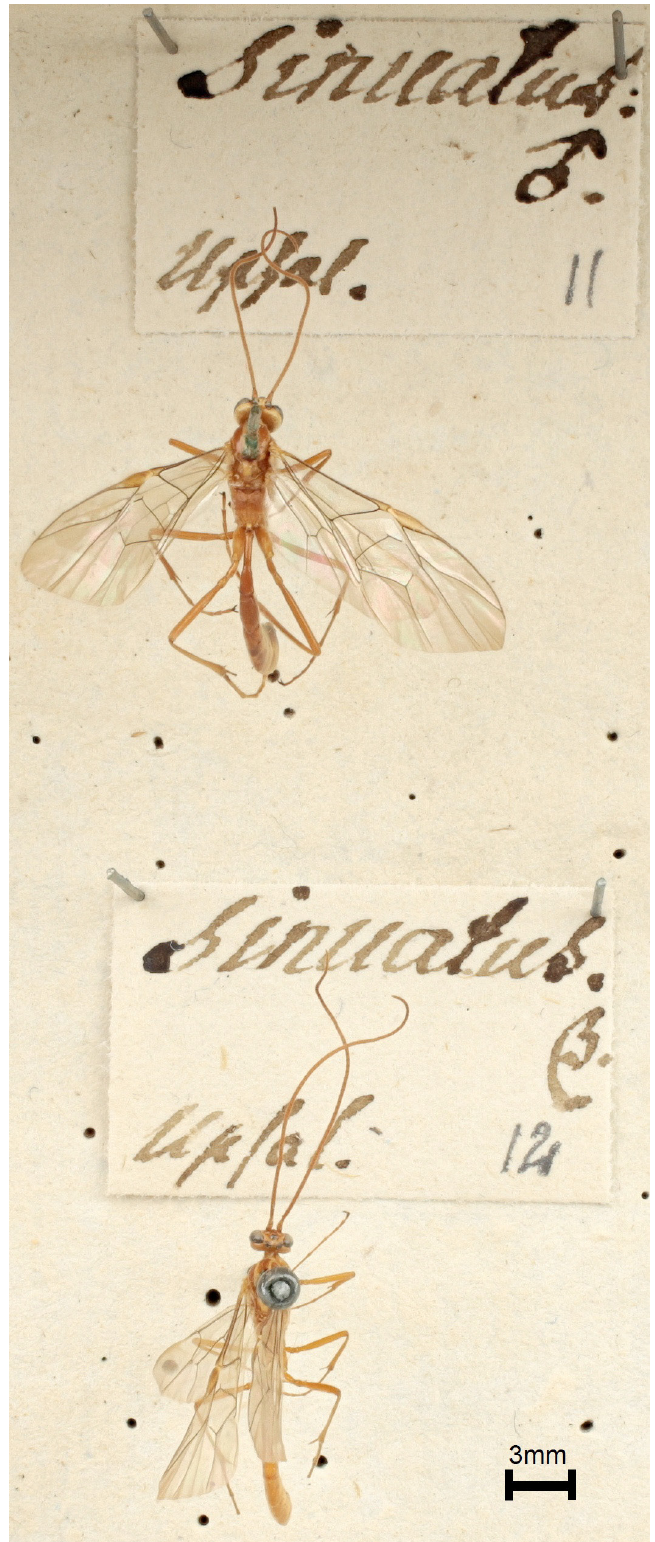
Fig. 49. The two specimens of Ophion variegatus rudow, 1883 in coll. Thunberg in UPSZ under the label Ophion sinuatus ( nomen nudum ). A female (labelled as male) above and male